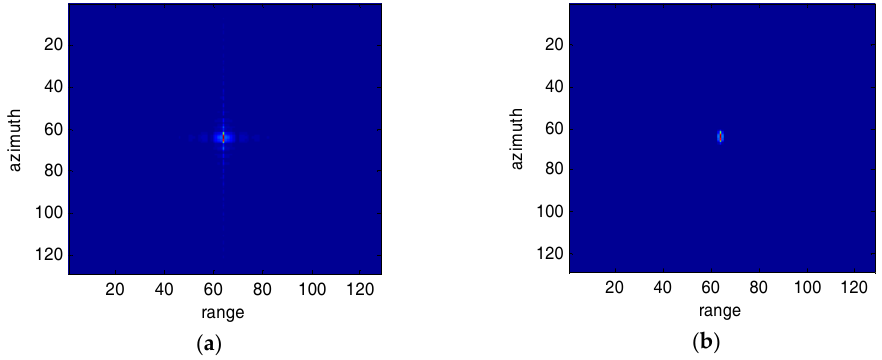
Figure 1. Impulse response for broadside SAR images ( a ) Original image; ( b ) SVA processed image.